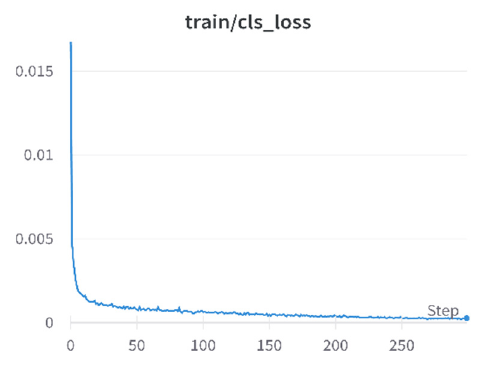
Figure 6. Training set classification loss.